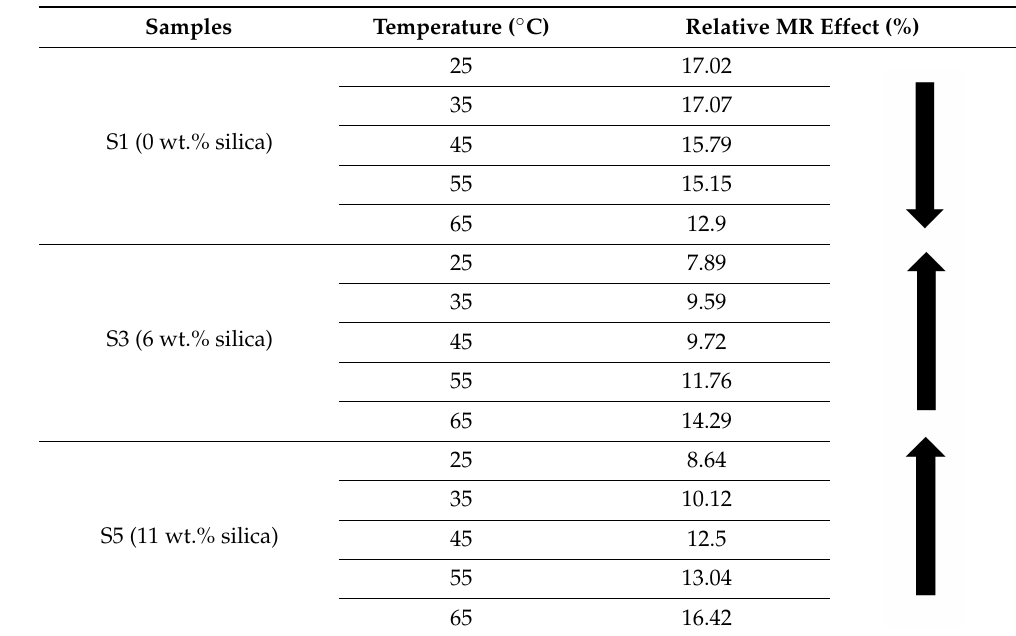
Table 3. The relative MR effect of EPDM-based MRE for various silica contents under different